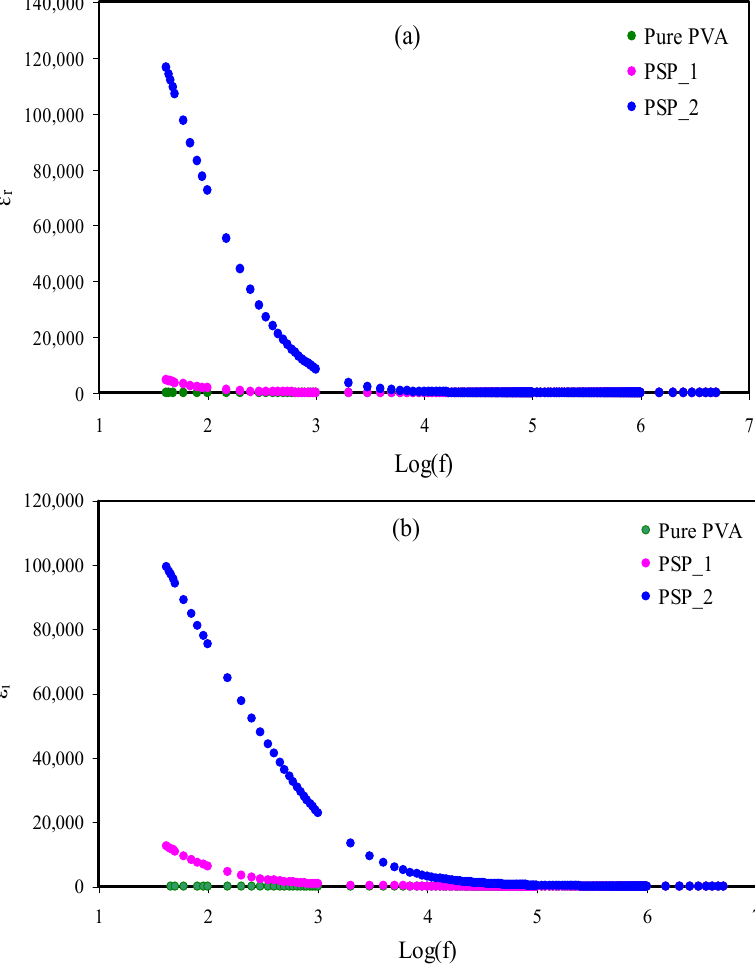
Figure 5. Dielectric plot of ( a ) ε r v log(f) and ( b ) ε i v log(f) for pure PVA, PSP_1, and PSP_2 electrolyte systems at RT.